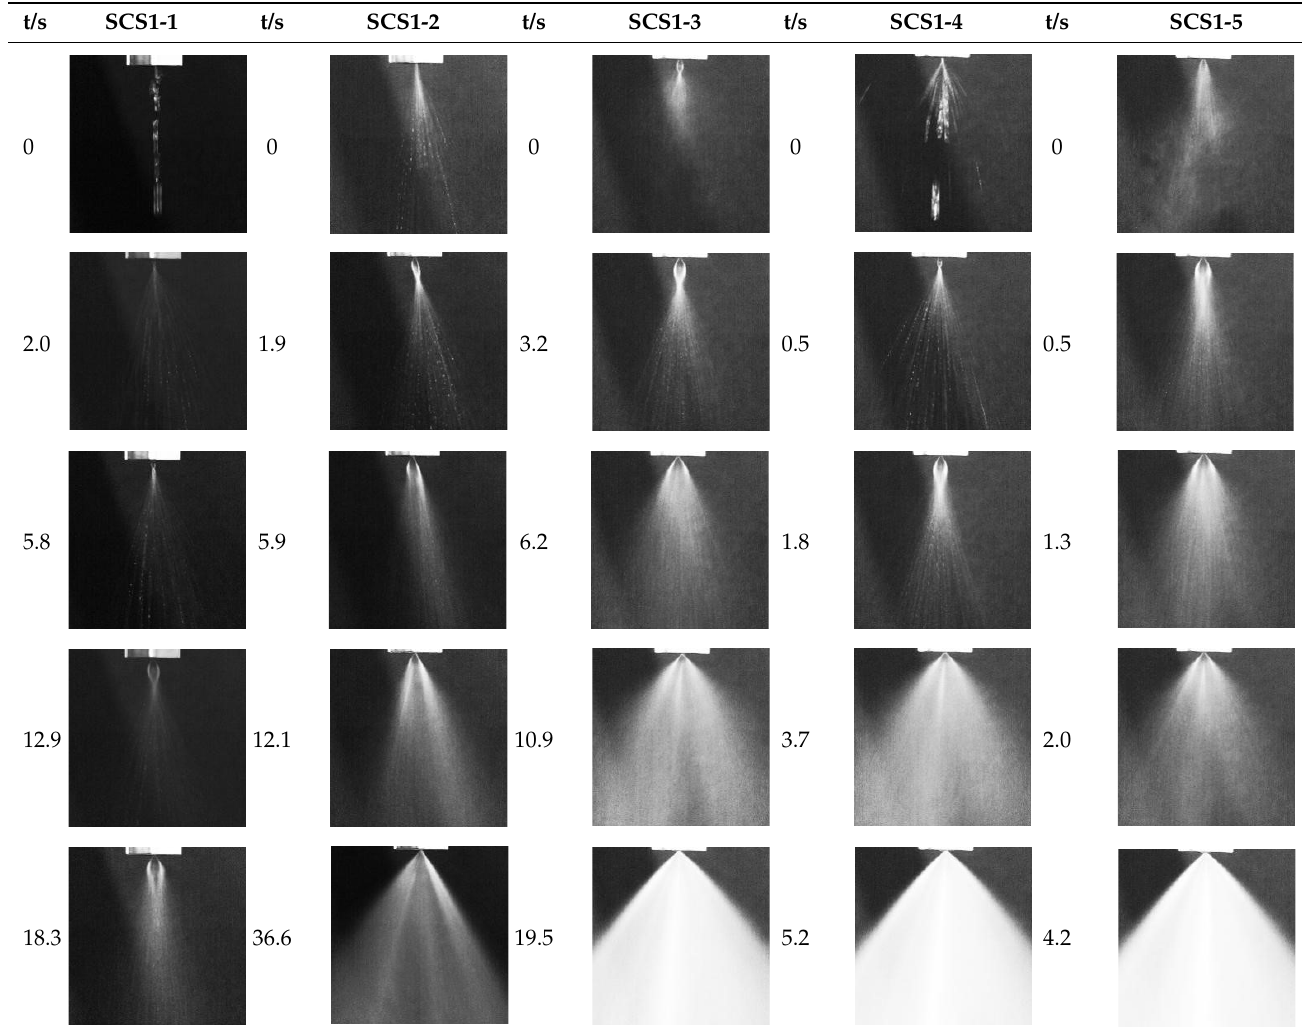
Table 5. Atomization process images of SCS1-injector.